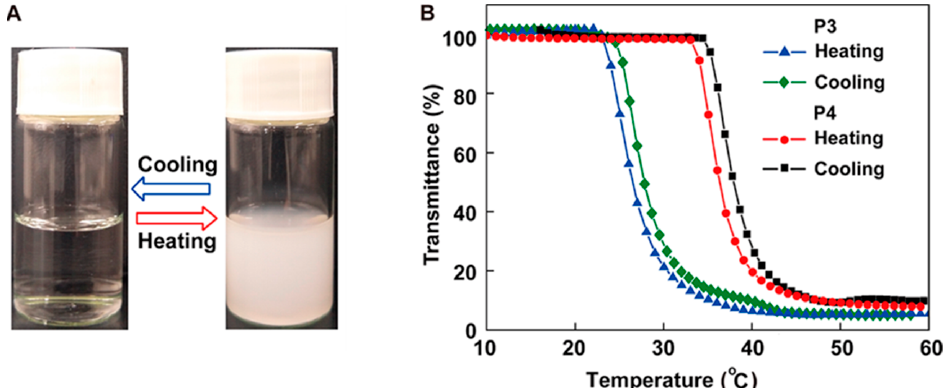
Figure 18. ( A ) Visual turbidity change of P4 upon heating the aqueous solution. ( B ) Temperature dependence of transmittance for the aqueous solutions (2 mg/mL) of P3 and P4 (500 nm, heating or cooling at a rate of 1 °C/min). Reproduced with permission [39]. Copyright 2018, American Chemical Society.